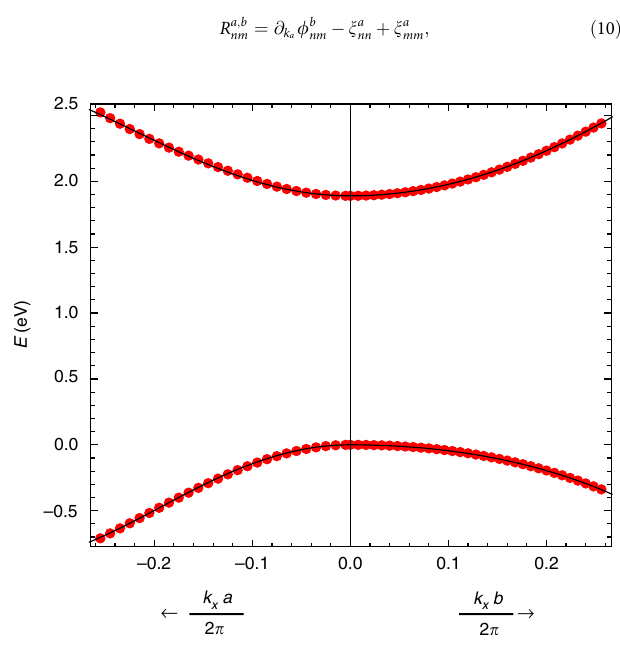
Figure 4 | Tight-binding fit to ab initio for GeS. Dispersion of conduction and valence bands of GeS near G computed ab initio (red dots). A black line shows the tight-binding fit for comparison.